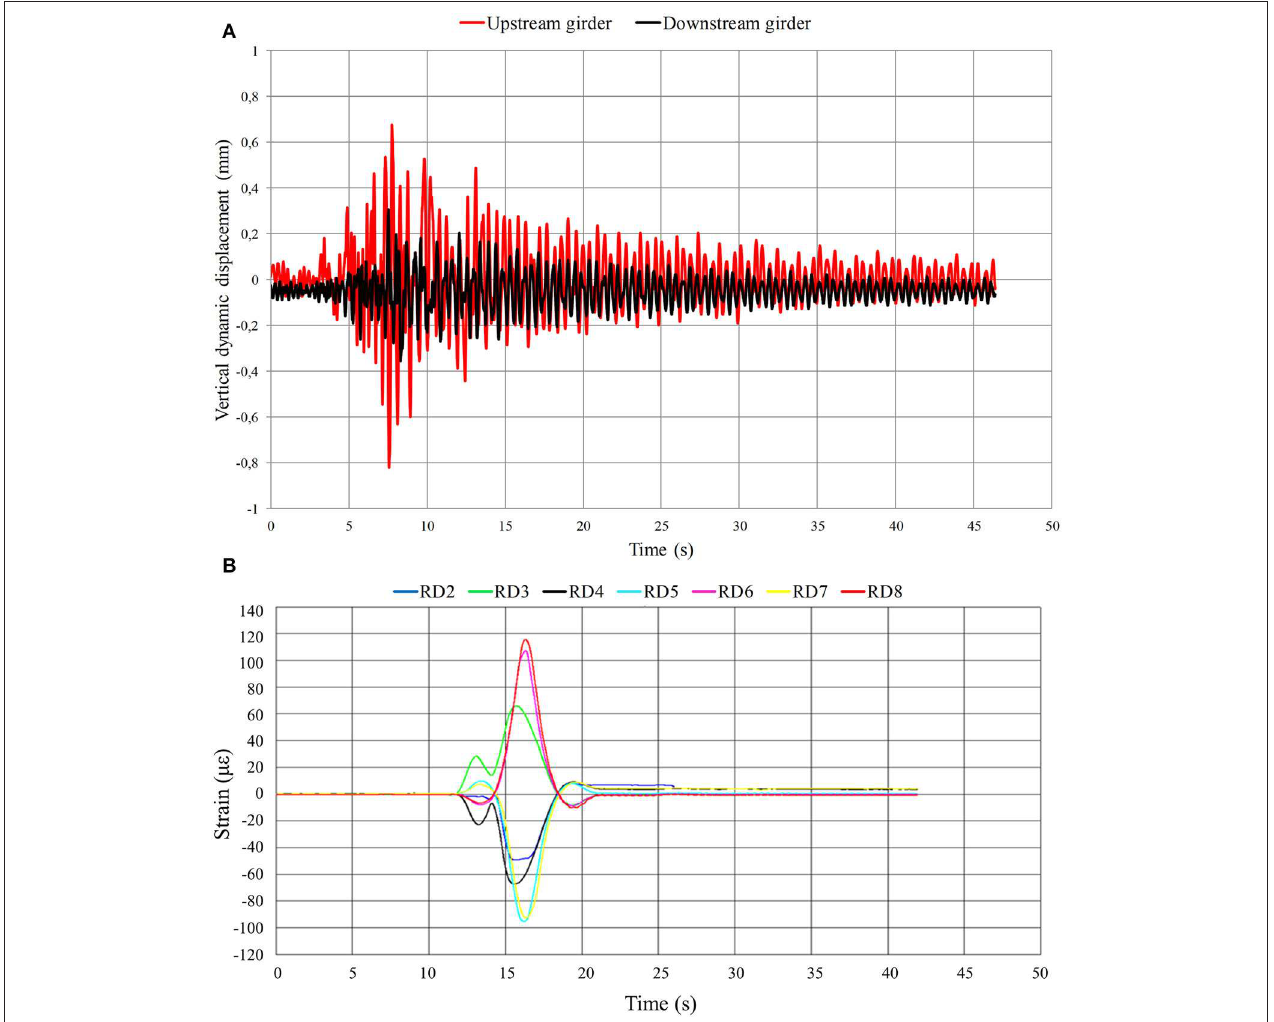
TABLE 3 | Measured dynamic displacements and calculated dynamic factors (Damjanovi´c et al., 2011). Number of locomotives 1 ( y stat =